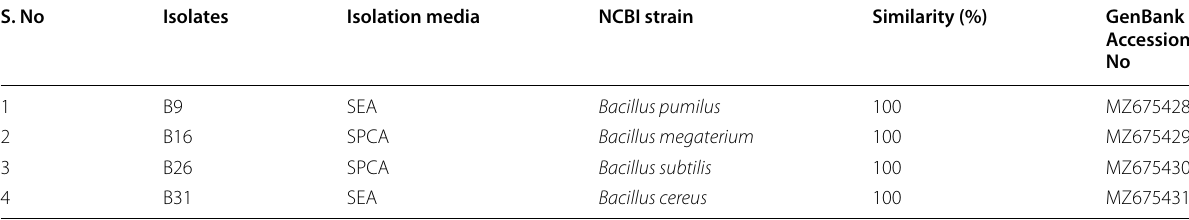
Homology and phylogenetic identity of the rhizobacterial isolates were obtained by comparing the 16S rRNA gene sequence similarity with that of related isolates available at the NCBI database SPCA, soil plate count agar, this media used for isolation of rhizosphere bacteria; SEA, soil extraction agar